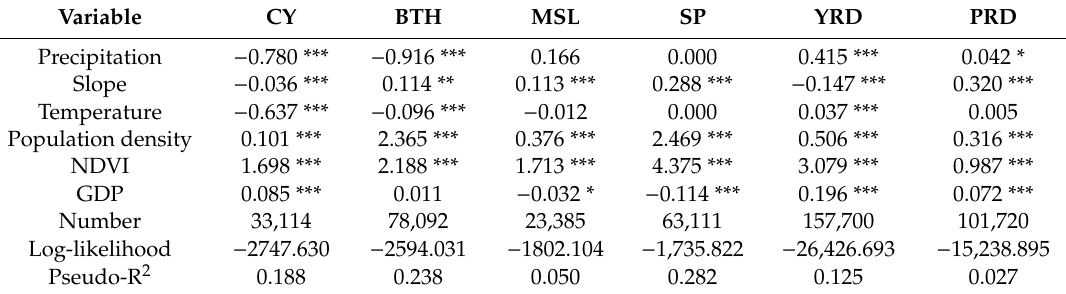
Table 2. Results of the probit model at the urban agglomeration level from